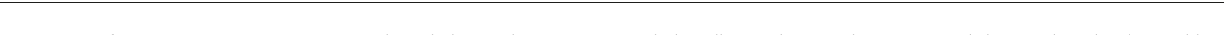
Fig. 6 Activation of VP projections to VTA recapitulates behavioral responses. a Whole-cell recordings in the VTA reveal that single-pulse (5-ms, blue dash) photostimulation of VGAT + VP terminals triggered PTx-sensitive IPSCs. Pie chart show the fraction of responding neurons, bar graphs show peak IPSC amplitude, insets shows individual cells pre- and post- PTx ( n = 7, paired t- test, t (6) = 3.2, p = 0.019); and representative trace; numbers inside bars represent sample size. b Cell-attached recordings in the VTA show that photostimulation of GABA terminals from the VP consistently reduced action potential fi ring frequency in the VTA ( n = 14, Wilcoxon matched-pairs signed-rank test, p = 0.0001). The black scatter plot shows mean change in fi ring rate 5-s before, during, and after 40-Hz photostimulation, gray axis and plots show individual neuron responses, inset (right) shows a representative trace. c VGAT-Cre mice displayed a preference for the compartment paired with photostimulation of VP terminals in the VTA on the RTPP assay ( n = 11) and showed ICSS over three daily sessions ( n = 4 YFP, n = 8 ChR2). d Whole-cell recordings, as described in a , show that photostimulation of VGLUT2 + VP terminals in the VTA triggered DNQX-sensitive EPSCs ( n = 5, paired t -test, t (4) = 3.75, p = 0.019); e and cell-attached recordings, as described in b , show that train of photostimulation increased action potential fi ring frequency in the VTA ( n = 14, Wilcoxon matched-pairs signed-rank test, p = 0.0001). f VGLUT2-Cre mice showed avoidance for the compartment paired with photostimulation of VP terminals in the VTA on the RTPP assay ( n = 6). Example images of ChR2:YFP and optic fi ber (OF) tracks in the VTA of c VGAT-Cre or f VGLUT-Cre mice; DAPI (blue), scale = 200 µ m. Scales for a and d are 50 pA, 50 ms and 200 pA, 50 ms, respectively; scale for b and e is 1 s; * p < 0.05, ** p < 0.01, *** p < 0.001. See also Supplementary Figure 7 and